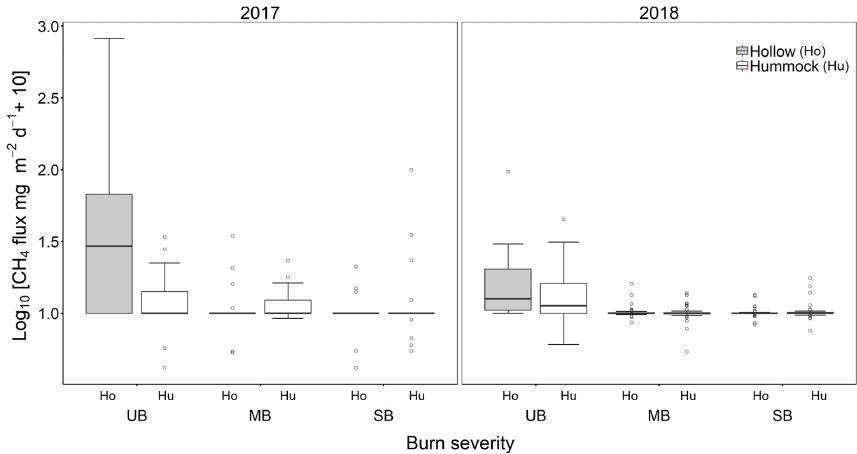
Figure 2. Methane (CH 4 ) emissions at each microform type across the peat burn severity gradient for 2017 and 2018. UB is unburned, MB is moderately burned and SB is severely burned. Note that CH 4 values were log transformed + 10; therefore, a value of 1 represents the measured value